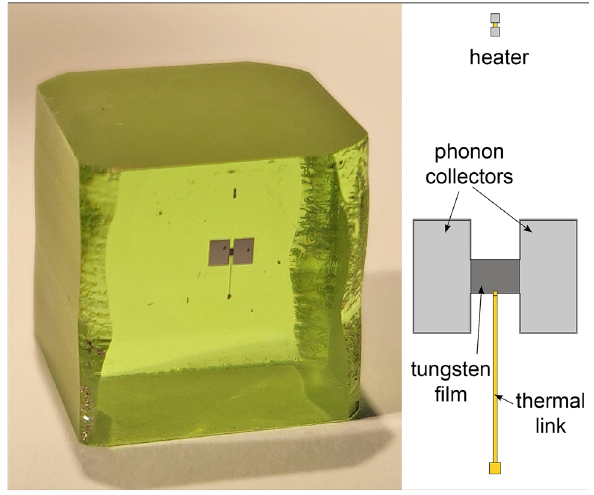
Fig. 2 Left Tm 3 Al 5 O 12 crystal after the TES deposition. It is possible to see two large aluminum phonon collectors (light gray) evaporated on top of a darker strip of tungsten. Closer to the upper edge of the crystal surfacethereistheheatermadeofathinstripofgoldwithtwoaluminum pads deposited on top. Right A sketch of a similar TES design